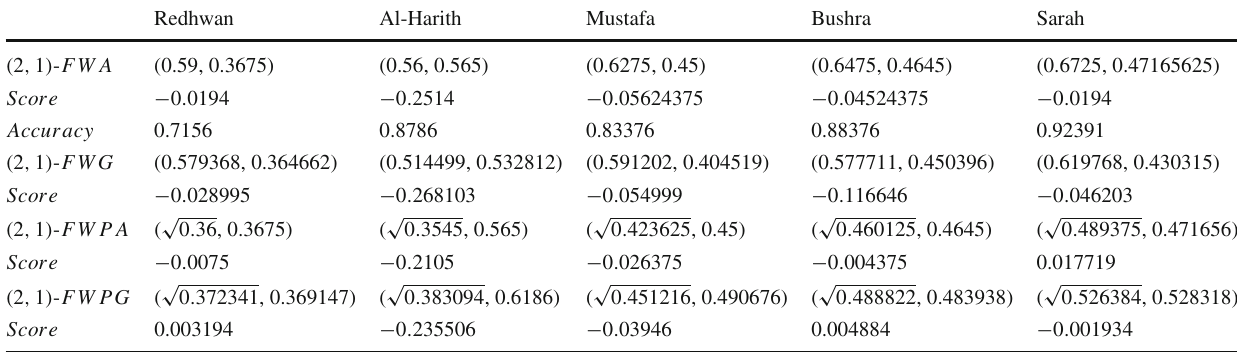
Table 2 Evaluation of scores with (2,1)-Fuzzy aggregation